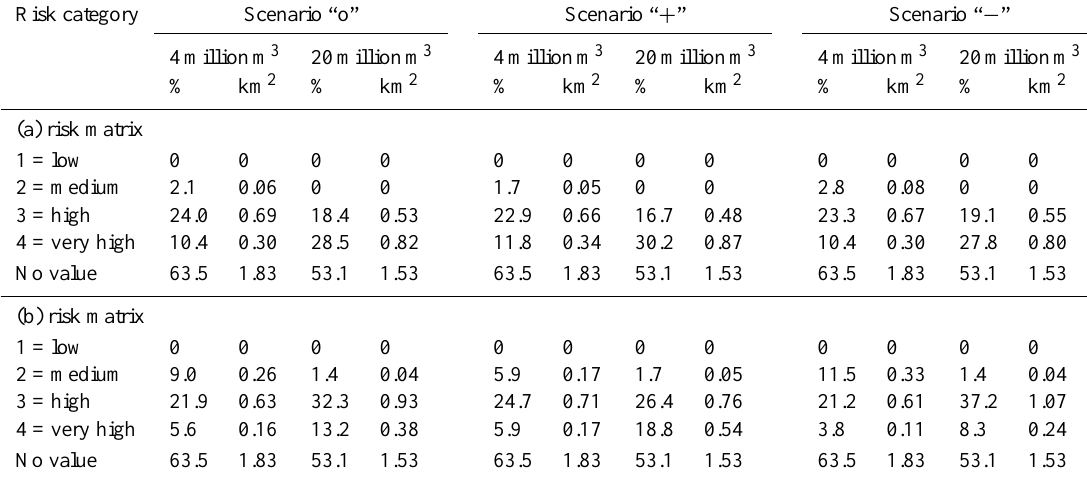
Table 5. Affected area per risk category as well as per land-use and intensity scenario. Total case study area = 2 . 88km 2 . Values in percent only refer to the affected area. The upper and the lower part of the table refer to the risk matrices (a) and (b) applying the intensity values 2 and 4 and 1 and 3 respectively.